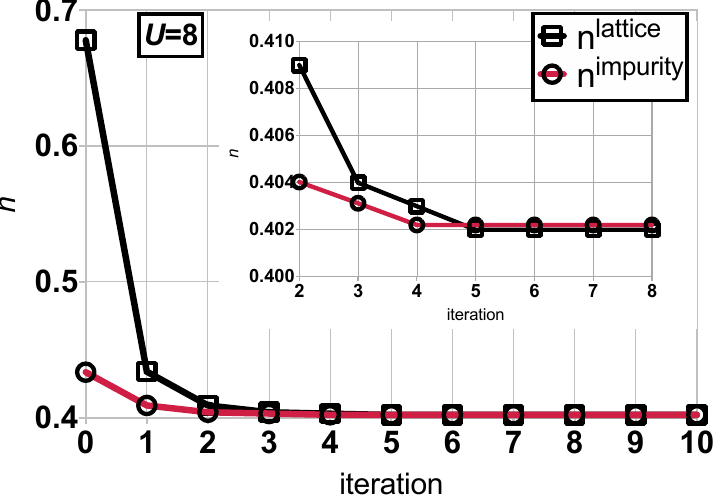
Figure 3. Comparison of the KS lattice and embedded impurity densities at each iteration of the LPFET calculation. The interaction strength and chemical potential values are set to U / t = 8 and µ / t = − 0.97, respectively. As shown in the inset, convergence is reached after five iterations.